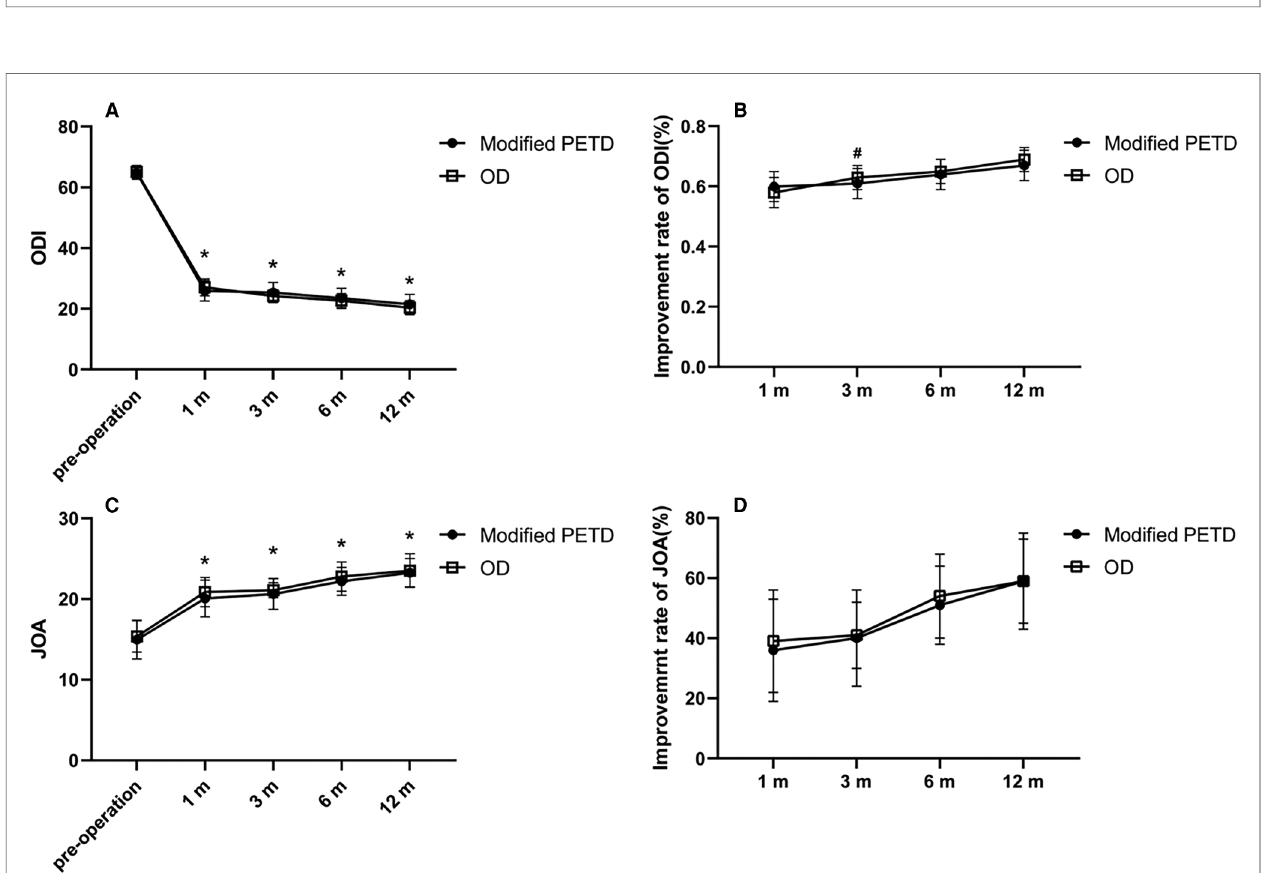
FIGURE 6 | Outcome values ( A ) and improvement rates ( B ) for the ODI. Outcome values ( C ) and improvement rates ( D ) for the JOA. * indicates statistical signi fi cance compared within groups ( P <0.01). # indicates statistical signi fi cance compared between groups ( P <0.05).